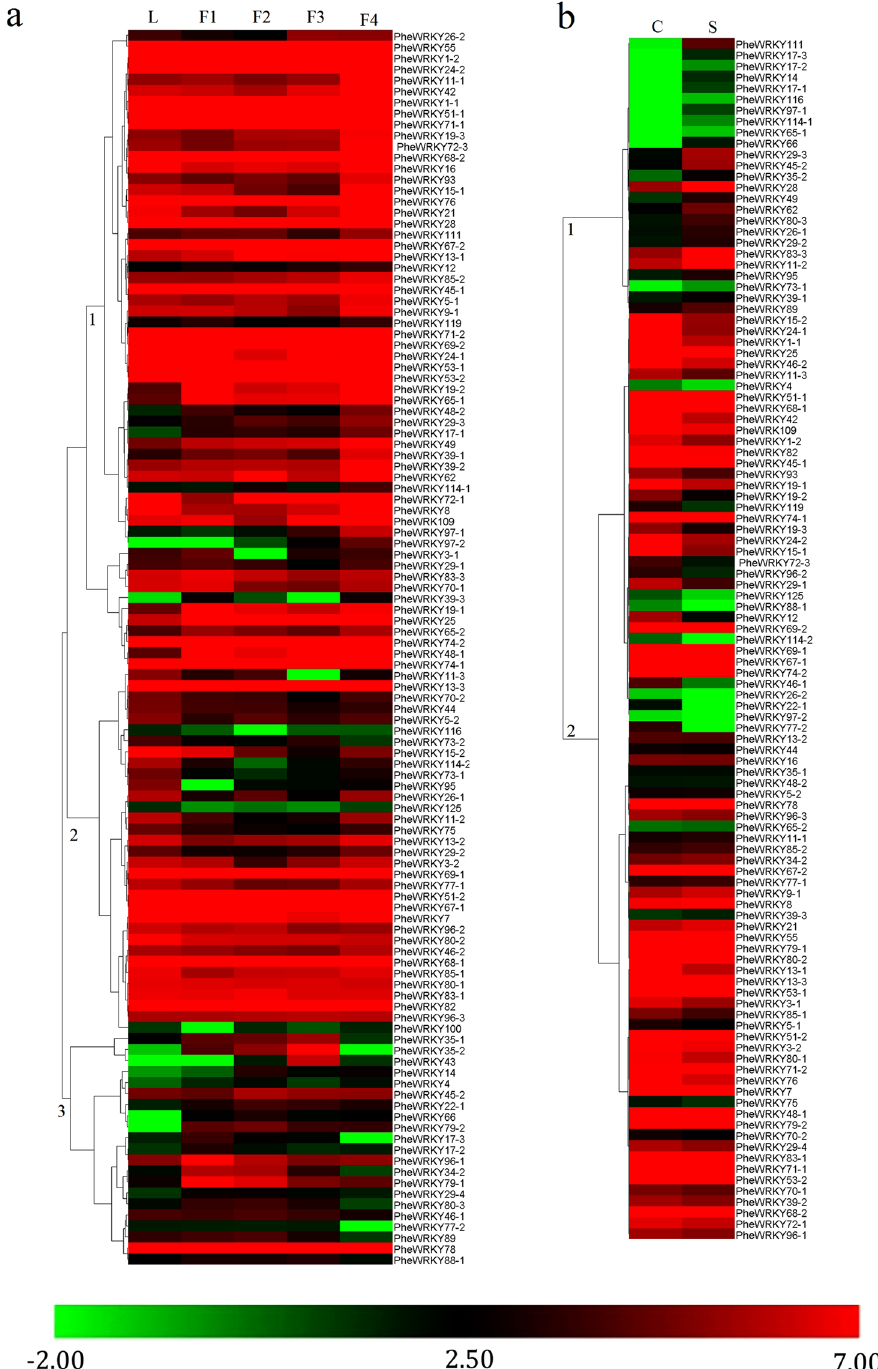
Figure 4. Expression profiles of the PheWRKY genes based on transcriptome data. The colour scale represents log2-transformed reads per kilobase per million (RPKM) values. Green indicates low expression, and red indicates high expression. (a) Dynamic expression profiles of four floral stages. F1, F2, F3, and F4 represent four different flowering developmental stages: the floral bud formation, inflorescence growing, blooming and embryo formation stages, respectively. (b) Expression profiles of the fast-growing shoot and